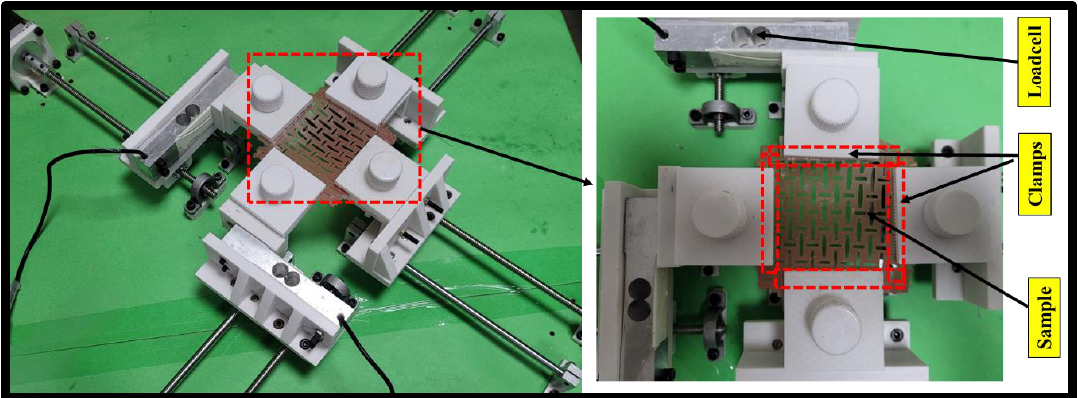
Figure 4. Sample attachment with 3D-printed clamps.